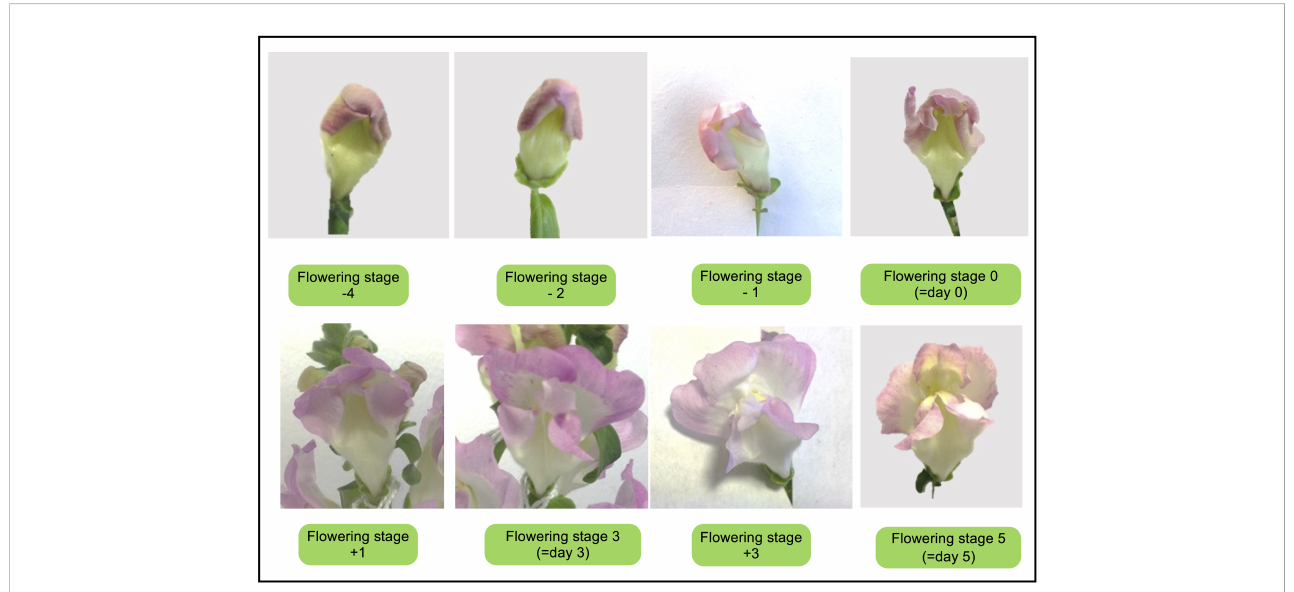
FIGURE 1 Flowering stages of Antirrhinum majus line 165E. Flowering stage range from -IV (before fl ower opening) until stage V (day 5 after fl ower